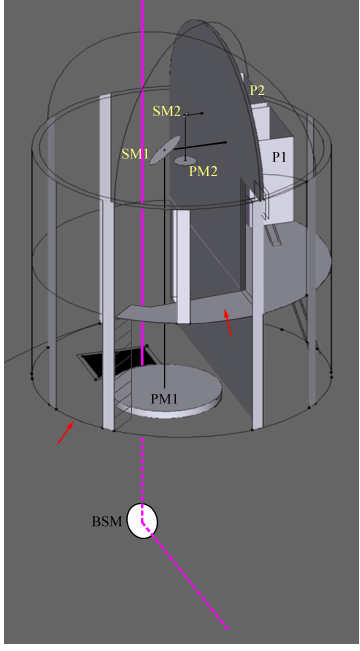
Figure 7. Receiver tower mounted on the terrace above the lidar laboratory. The tower is covered by a 4.2m diameter astronomical dome with a 1.5m slit. The laser beam (violet) emerges from a for- mer emergency shaft. The plane formed by the axes of the large telescope and the laser beam contains the section of the laser beam in the lower floor. This plane is perpendicular to the plane formed by the axes of the small telescope and the laser beam. Abbreviations: BSM: beam-steering mirror; PM: primary mirror; SM: secondary mirror; P: Polychromator; 1, 2: belonging to far-field receiver, near- field-receiver, respectively. The two red arrows indicate the two en- trances of the